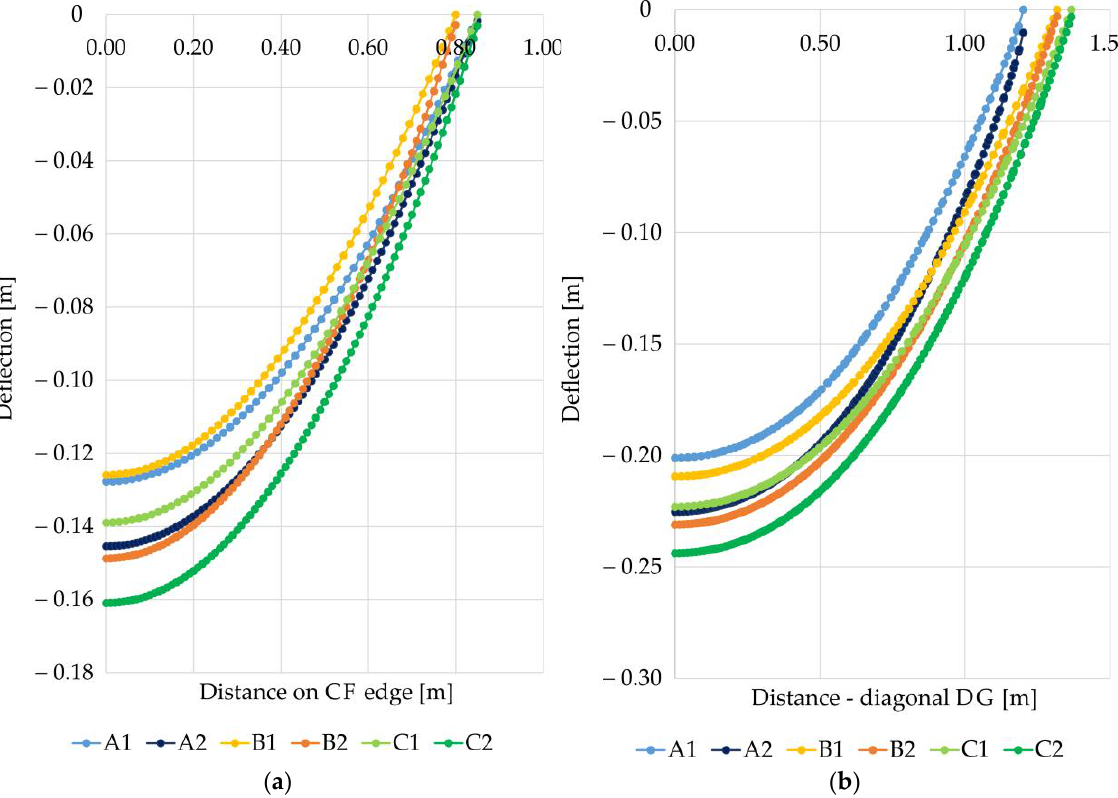
Figure 11. Deflection of the membrane modeling reinforcement depending on the adopted variant; reinforcement stiffness J = 1615 [kN/m]: ( a ) on the edge CF (between columns); ( b ) on the diagonal DG.